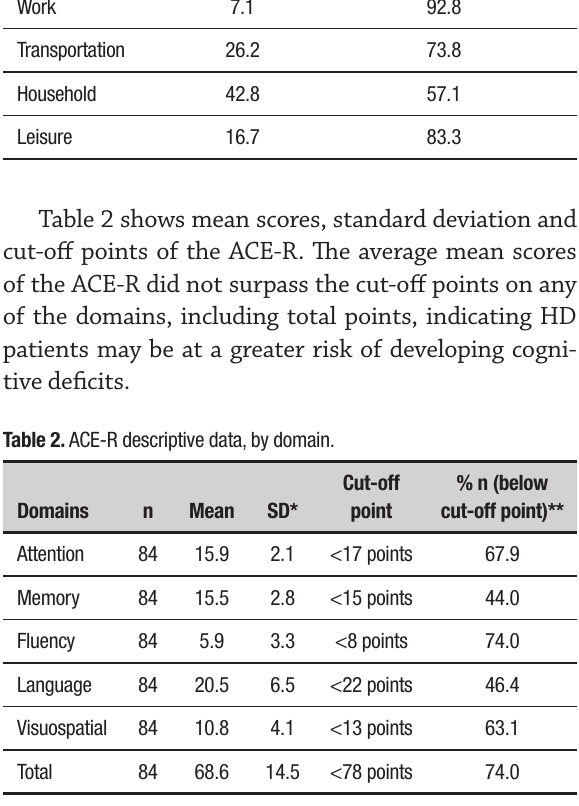
Table 1. Prevalence of active and insufficiently active HD patients, by domain. Domains